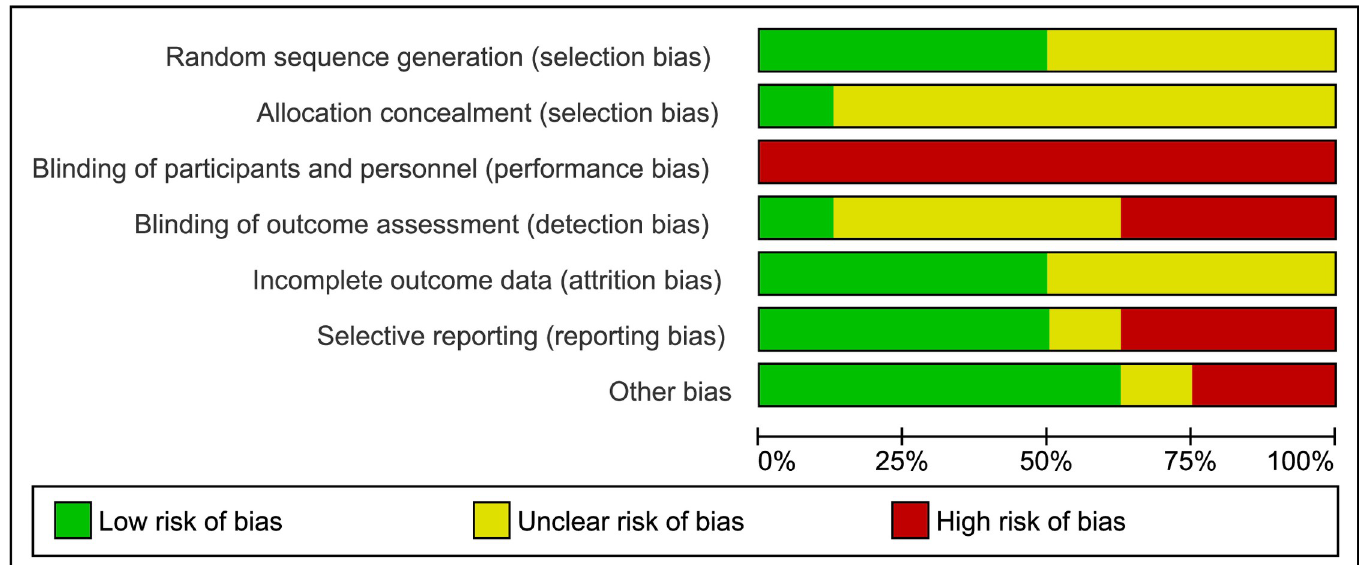
Fig 3. Risk of bias graph: Review authors’ judgements about each risk of bias item presented as percentages across all included studies.